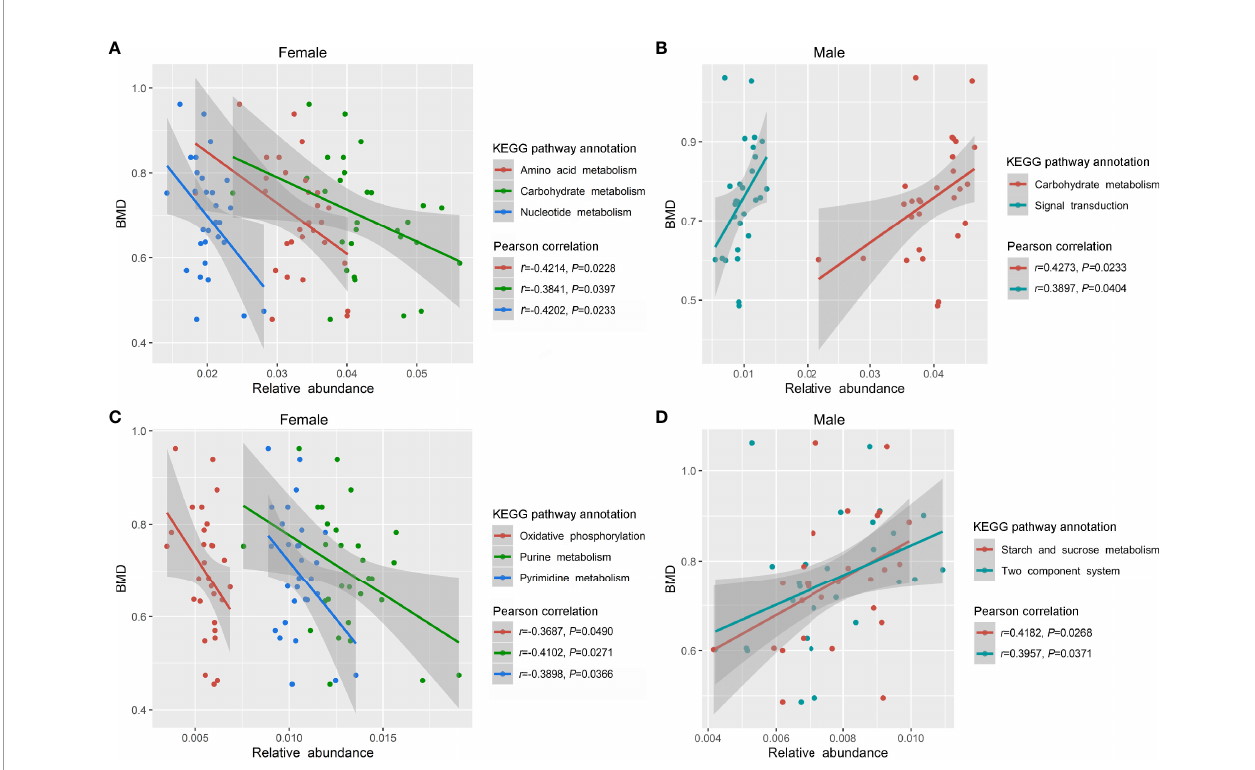
FIGURE 5 | Relative enrichment of KEGG functional annotation and their correlation with BMD values in females and males. (A) Relative enrichment of carbohydrate metabolism, amino acid metabolism, nucleotide metabolism, and their correlation with BMD values in females. (B) Relative enrichment of carbohydrate metabolism, signal transduction, and their correlation with BMD values in males. (C) Relative enrichment of purine metabolism, pyrimidine metabolism, oxidative phosphorylation, and their correlation with BMD values in females. (D) Relative enrichment of two-component system, starch and sucrose metabolism, and their correlation with BMD values in